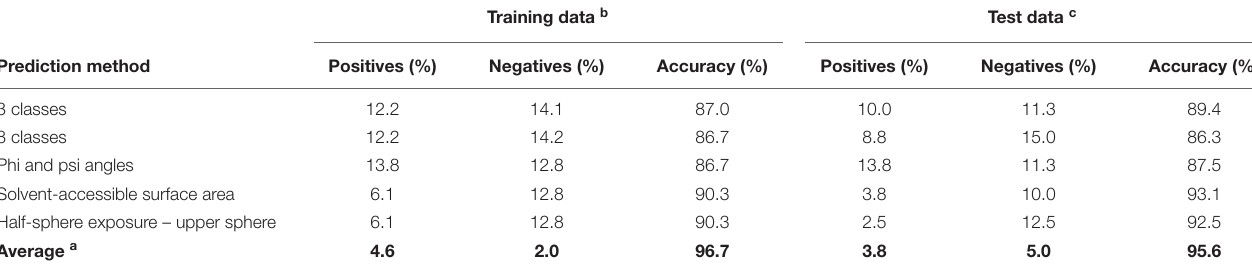
TABLE 5 | Percentage of prediction misclassifications and the accuracy per secondary structure prediction method for Babesia bovis T2Bo training and test